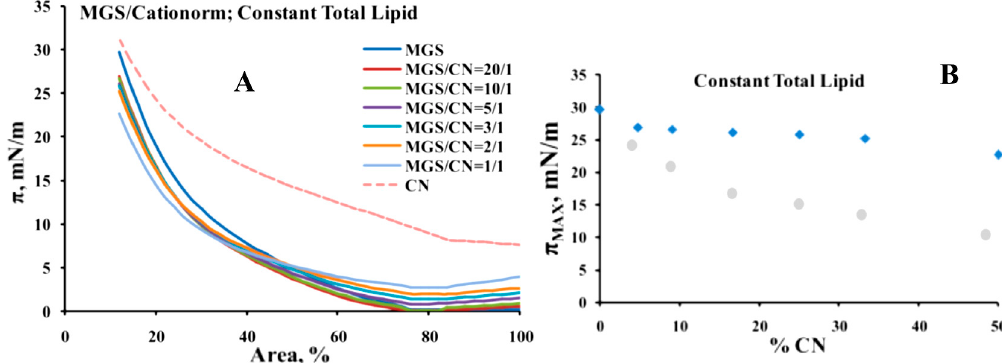
Figure 2. ( A ) Surface pressure area isotherms of MGS/CN pseudobinary films obtained at constant total lipid (i.e., the inclusion of CN oil was accompanied by proportional decrease of the MGS amount at the interface); ( B ) Dependence (blue rhombs) of maximum surface pressure, π MAX , on CN content at fixed MGS amount (the grey circles shows the inability of pure MO to assist MGS in maintenance of high value of π MAX ).